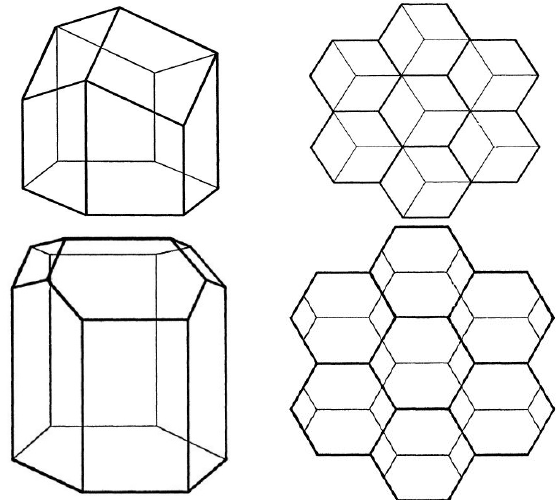
Figure 1. Honeycomb structures [1].